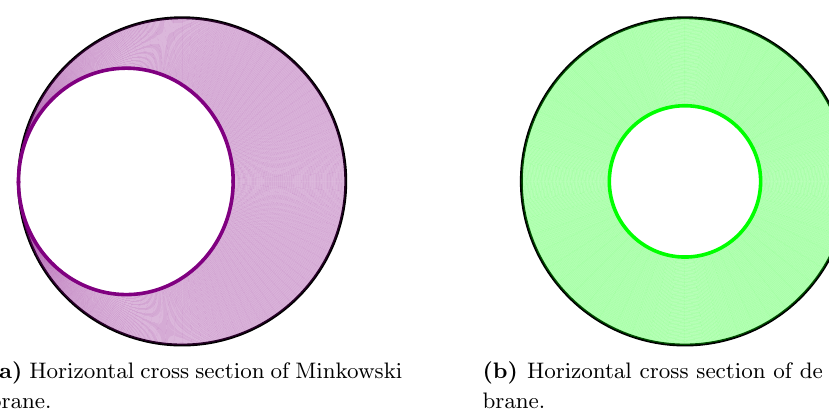
Figure 5. Euclidean embeddings of critical and supercritical brane. This is equivalent to the horizontal cross sections of Minkowski and de Sitter